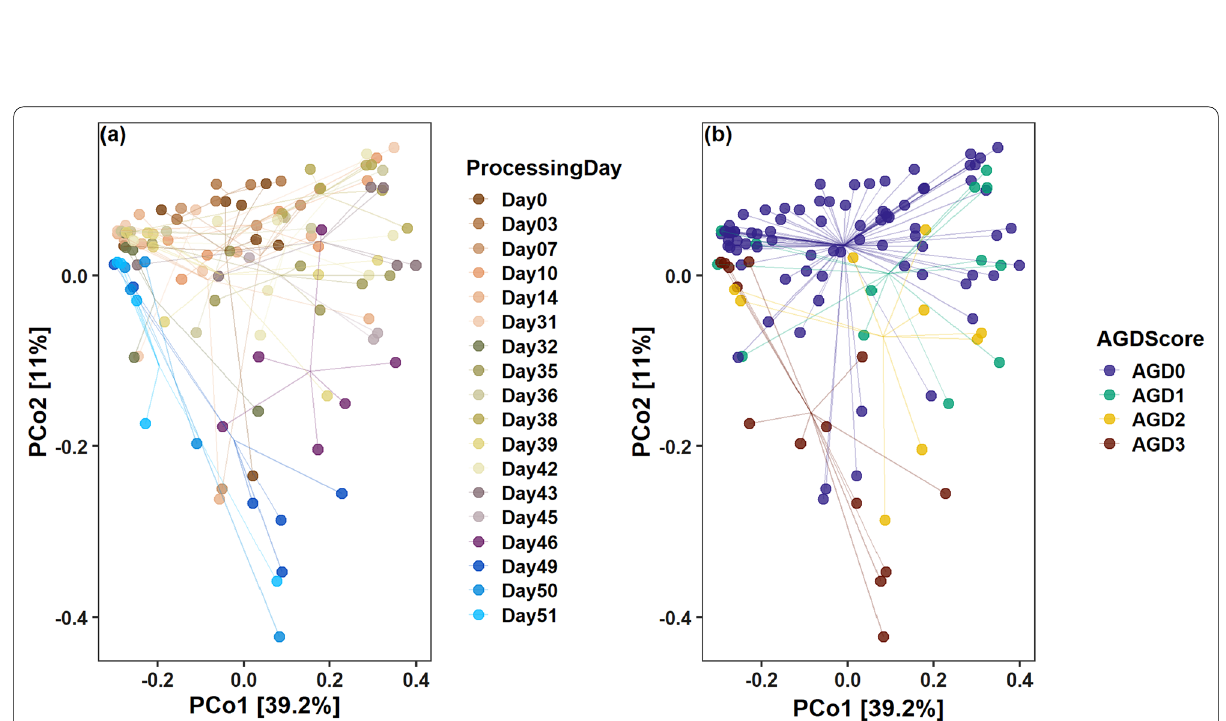
Fig. 7 Principal coordinates analysis (PCoA) derived from weighted UniFrac distances among PC samples from starved fish. Samples are coloured according to the day when fish were dissected ( a ). Thereby, Day 0 marks the start of the respirometry experiment. b shows the same distribution, but here samples are coloured according to the associated AGD severity level. Connected lines mark the position of the different group